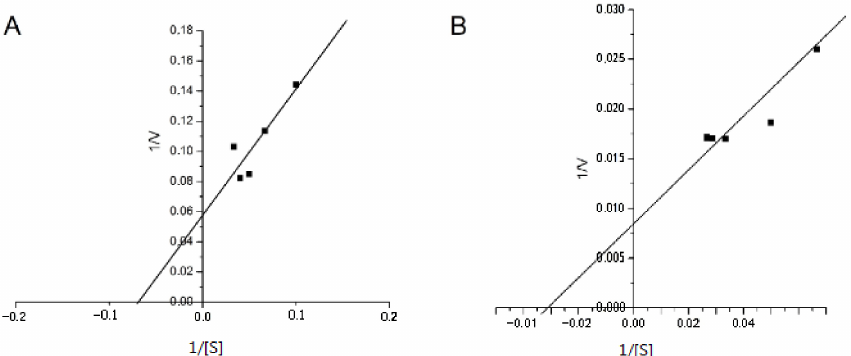
Figure 3. Determination of the kinetic parameters of the IgG SOD reactions using the Lineweaver– Burk plot. ( A ) IgG from healthy person; ( B ) IgG from patient with acute